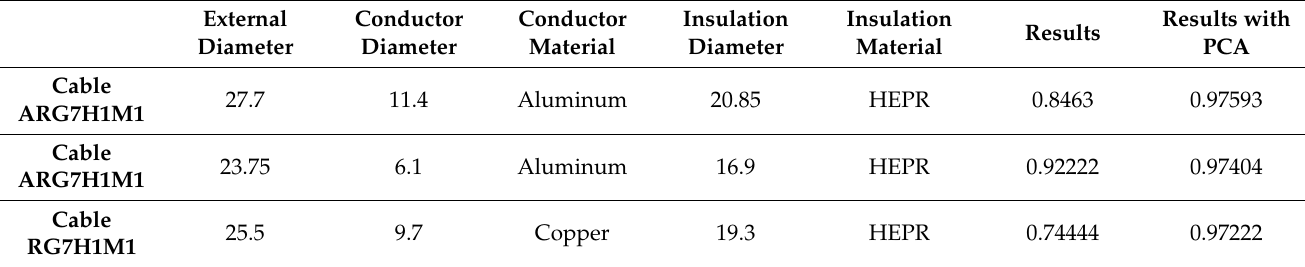
Table 10. Results obtained with different types of